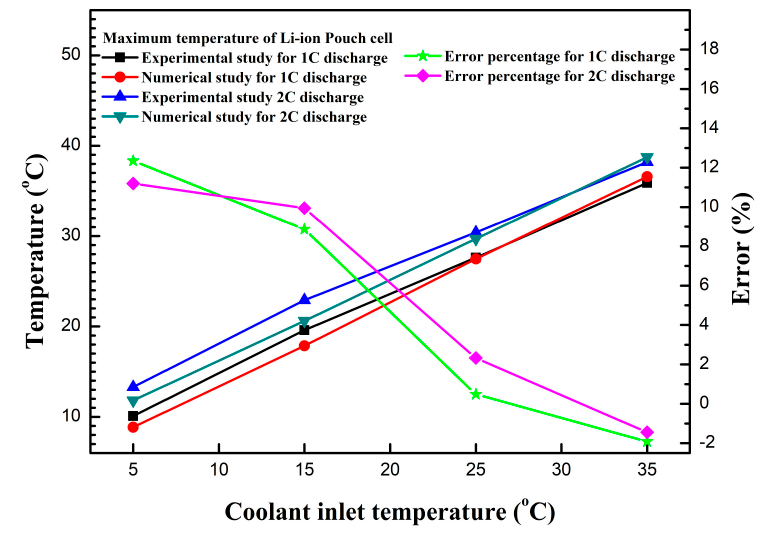
Figure 4. Validation [20].